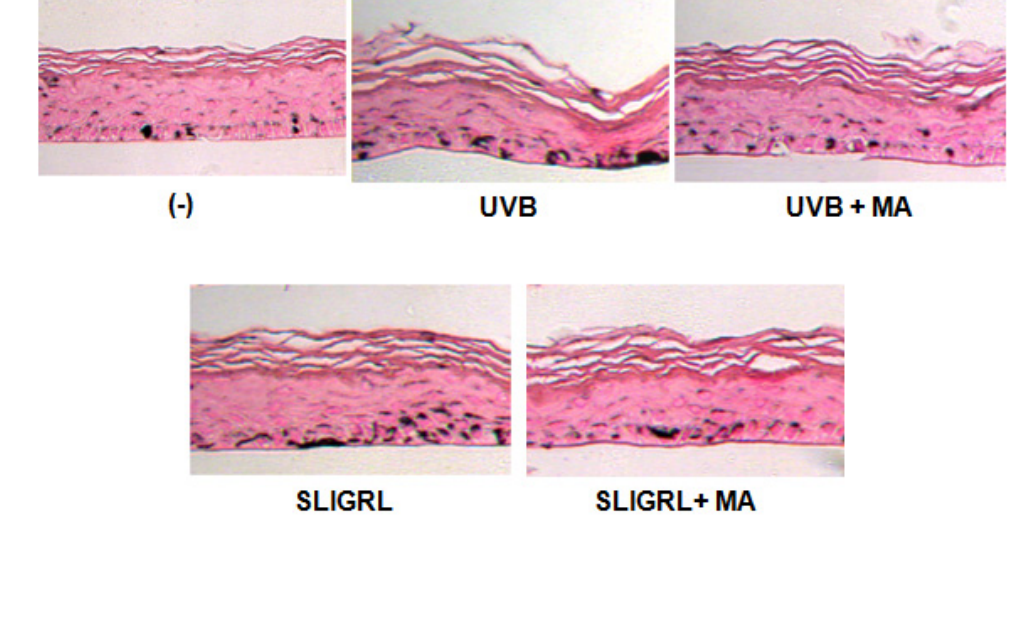
Figure 5. Effect of MA on reconstructed epidermis. Application of MA decreased melanin pigmentation induced by UVB radiation and SLIGRL in reconstructed epidermis. Histological sections after Fontana-Masson